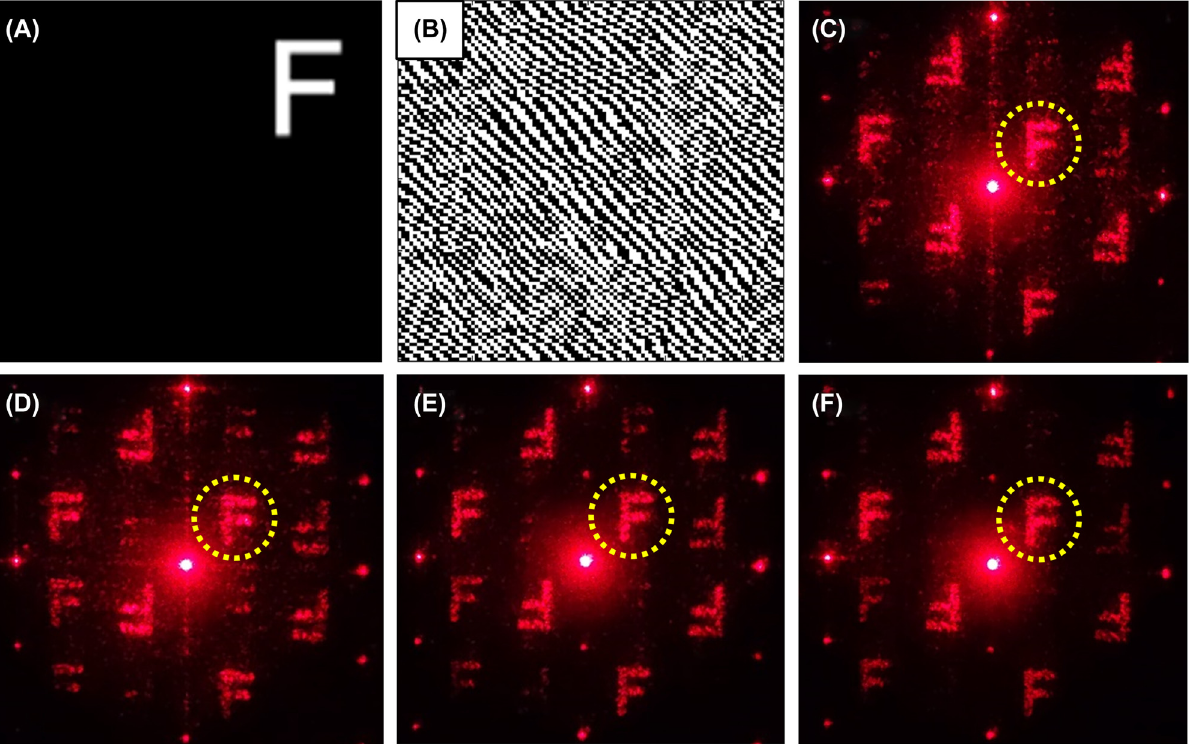
Figure 2: Holograms performance characterization with different double-pulse time intervals. (A) Target reconstruction image, (B) corresponding calculated binary hologram, optical diffraction images reconstructed from the holograms fabricated by single-pulse (C), 150 fs (D), 350 fs (E), and 700 fs (F) double-pulse time intervals,